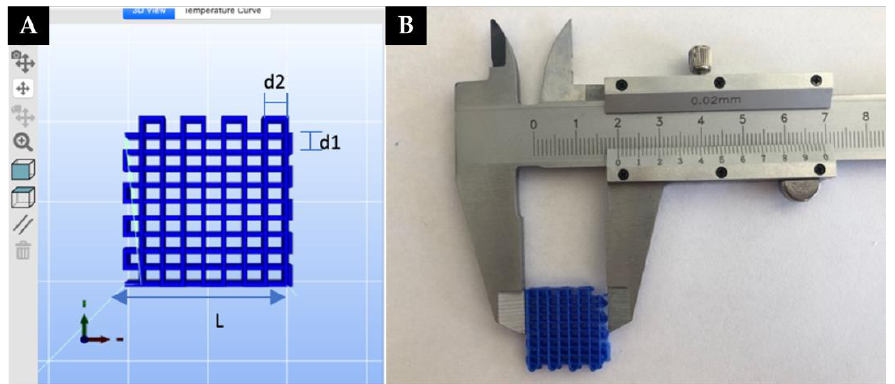
Figure 5. ( A ) Rectilinear geometric model of a scaffold generated in Repetier Host. ( B ) Printed scaffold measured with a caliper to test the shape and size fidelity. d1 is the distance between printed strands in the X-axis, and d2 in the Y-axis.